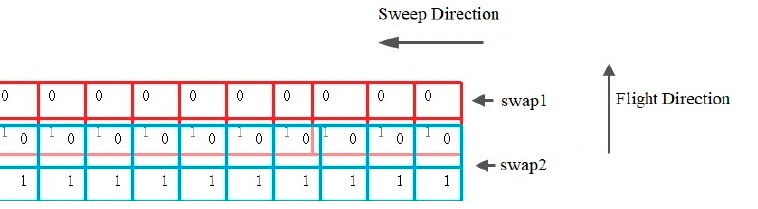
Figure 4. Relationship among Consecutive Swap. Number 0 represents images captured by lenses 0, number 1 represents images captured by lenses 1.